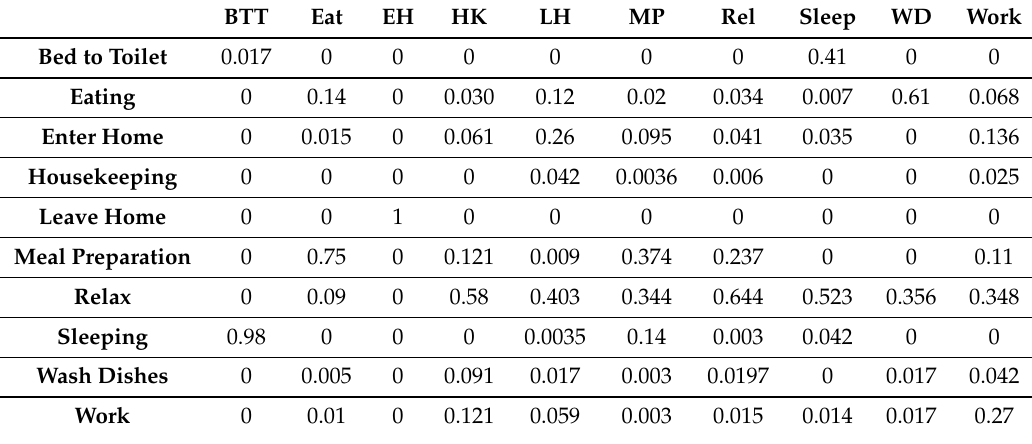
Table 6. Transition Probability of Activities.